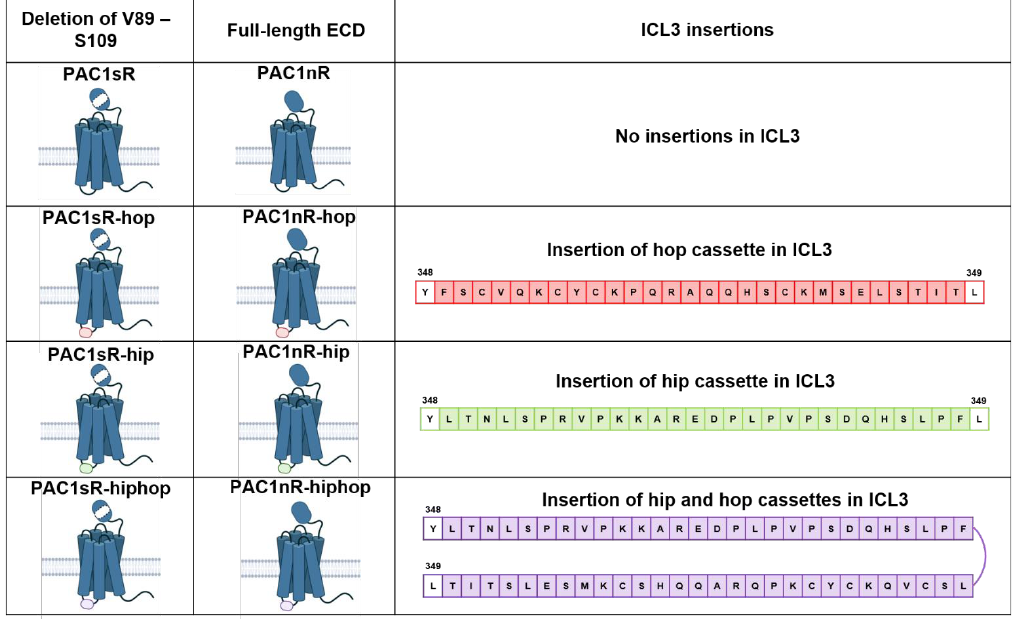
Figure 2. Schematic illustration of PAC1R splice isoforms occurring in the N-terminal extracellular domain (ECD) and/or intracellular loop 3 (ICL3) in humans. N-terminal ECD splice variation arises from the presence (PAC1R null a.k.a. PAC1nR) or deletion (PAC1R-short a.k.a. PAC1sR) of 21 amino acids (residues V89 to S109) from the N-terminal ECD. ICL3 splice variation arises from the inclusion of one or two of the cassette exons, the “hip” cassette (red) and the “hop” cassette (green) of 28 amino acids each, between residues Y348 and L349 of the PAC1R ICL3. Inclusion of the hip cassette in PAC1R leads to the splice isoform PAC1nR-hip or PAC1sR-hip. Inclusion of the hop cassette leads to the PAC1nR-hop or PAC1sR-hop splice isoform, while the inclusion of both hip and hop cassettes leads to PAC1nR-hiphop or PAC1sR-hiphop (purple).